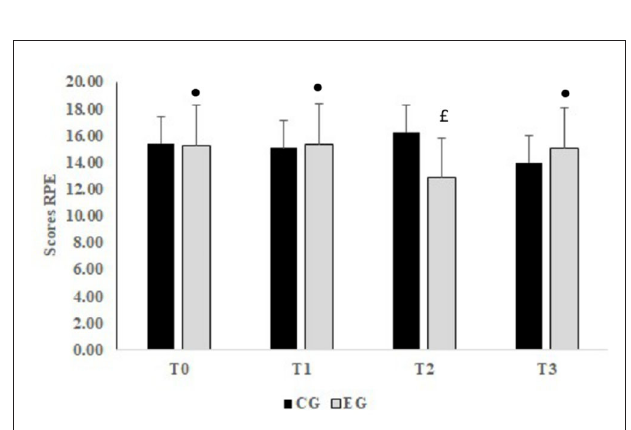
FIGURE 4 | Mean values ± standard deviation (SD) for RPE (rating of perceived exertion) registered before Ramadan (T0), in the second week of Ramadan (T1), in the fourth week of Ramadan (T2) and after Ramadan (T3) in CG ( n = 12) and EG ( n = 12). •, Significant difference compared to T2; £, Significant difference compared to